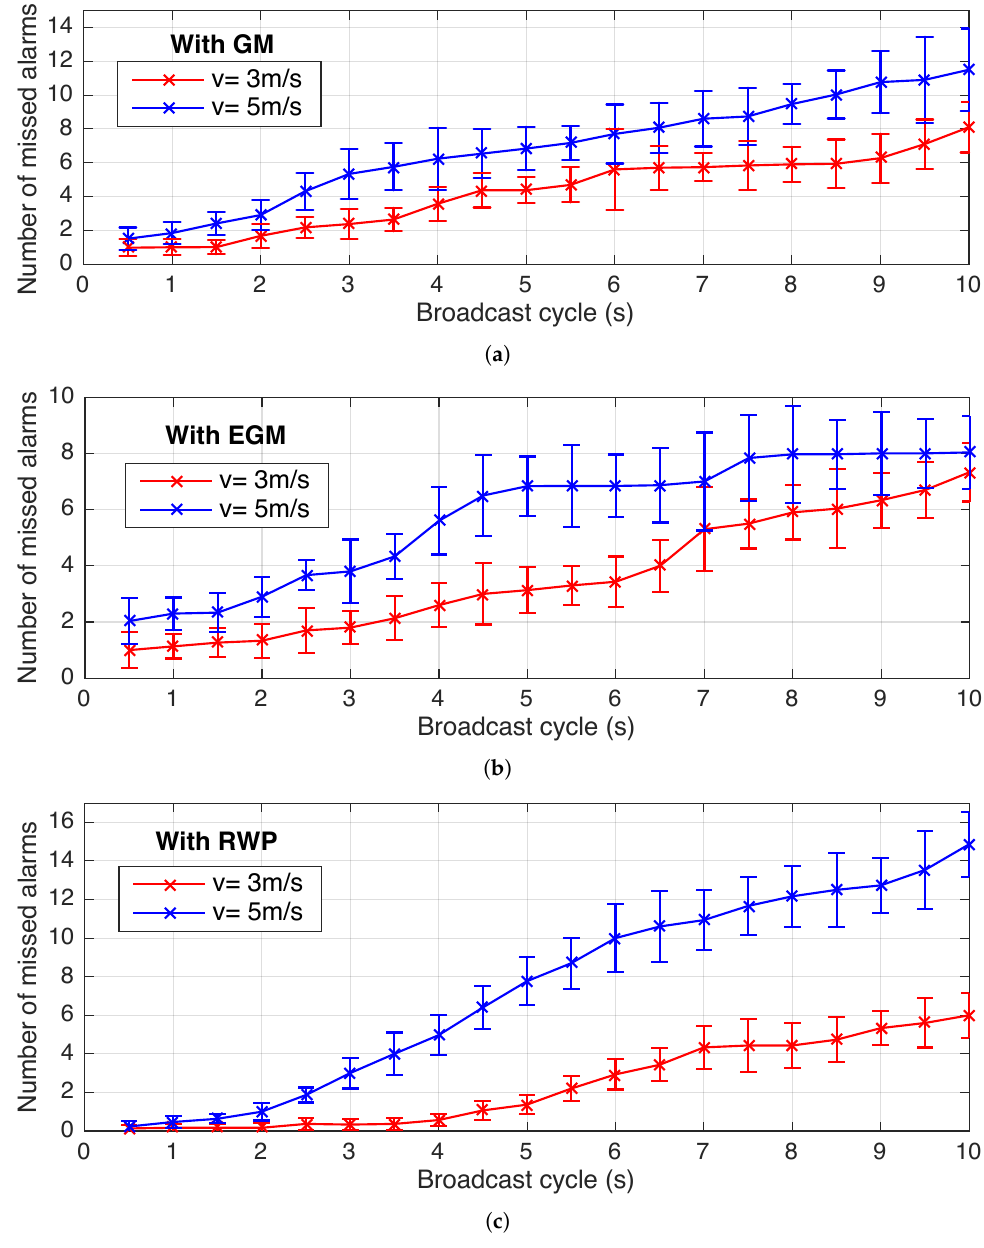
Figure 6. Average missed alarms under different T b using ( a ) GM; ( b ) EGM; ( c )